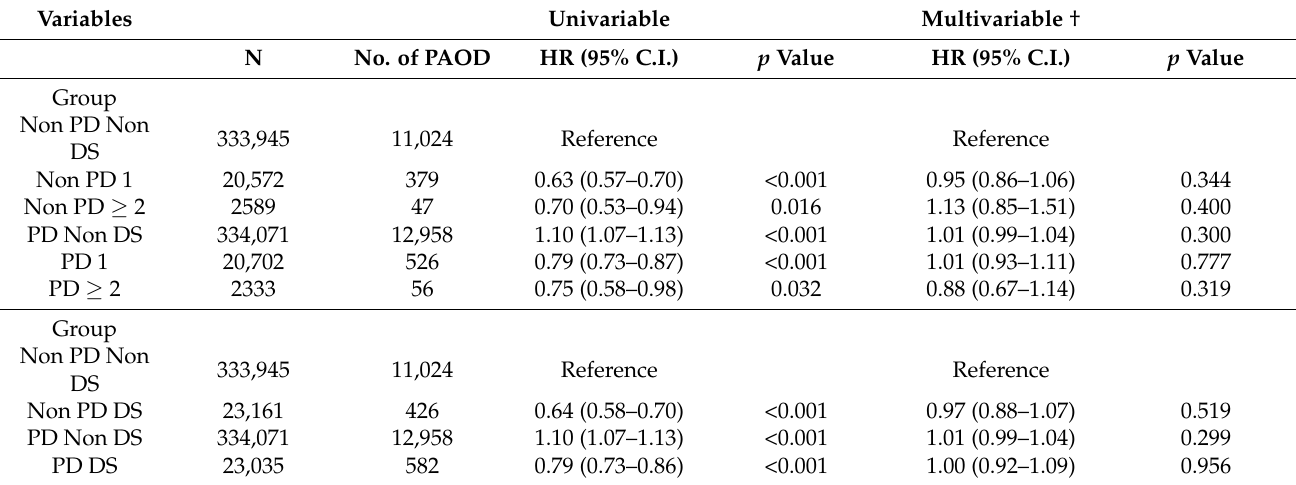
Table 5. Cox proportional hazard model analysis for risk of PAOD with and without dental